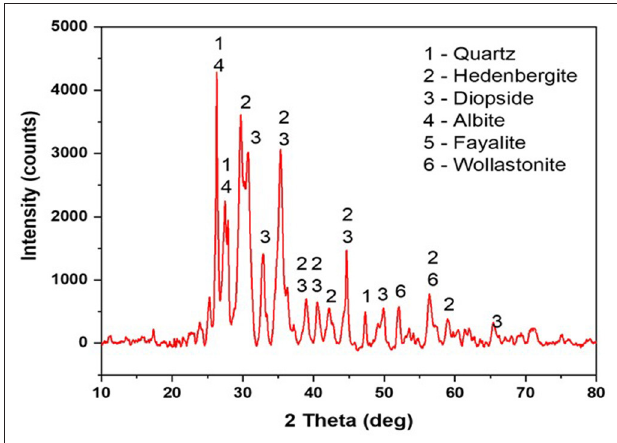
MJ/kg, whereas 24.9 MJ/kg was for the pretreated ASR. For any